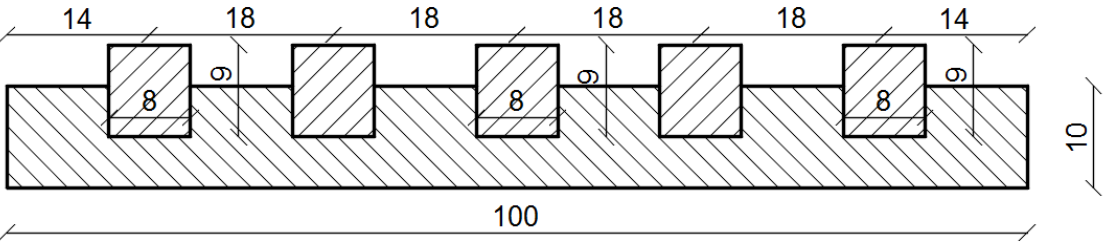
Figure 1 2. Diagram of the test sample—dimensions are expressed in cm. Figure 12. Diagram of the test sample—dimensions are expressed in